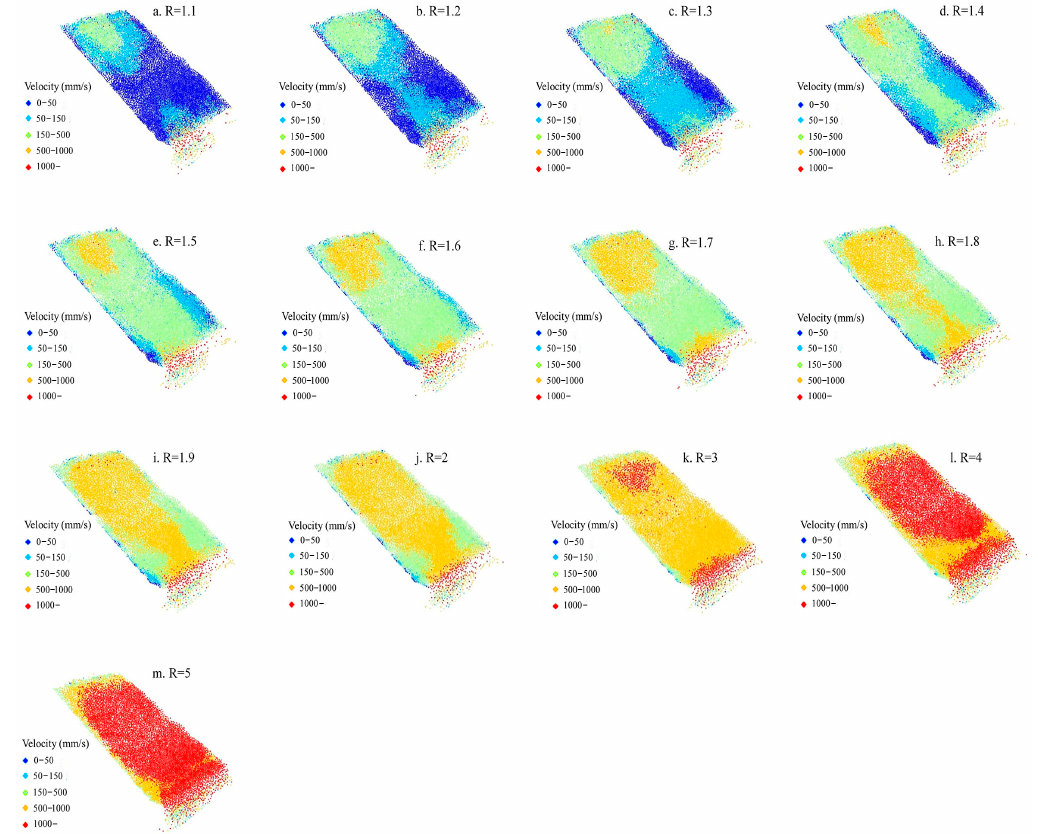
Figure 10. Kinetic features map of the Jinpingzi landslide with different reduction coefficients (R).